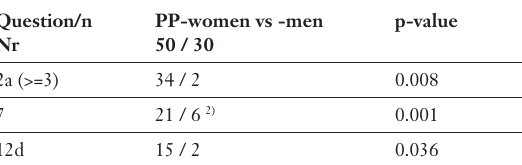
between the three groups were different: PP 50 years (SD = 14), OP 57 (15) and OD 62 (13).